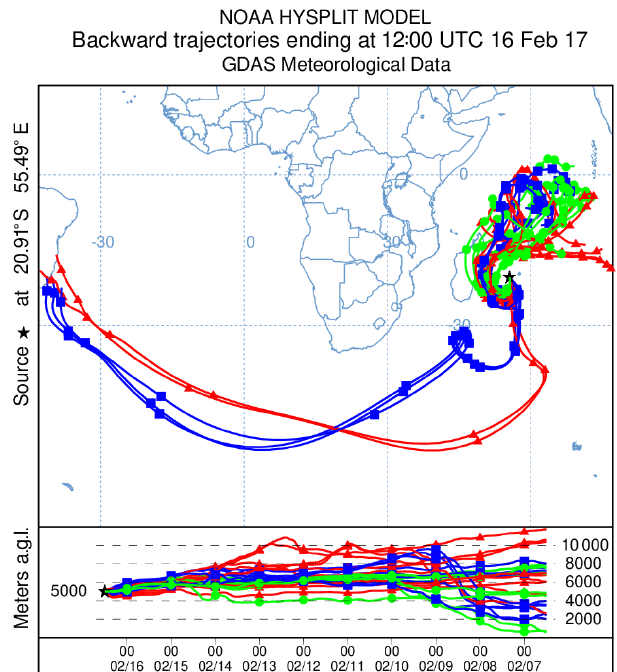
Figure 19. Same as Fig. 18 but for the TCCON Réunion Island